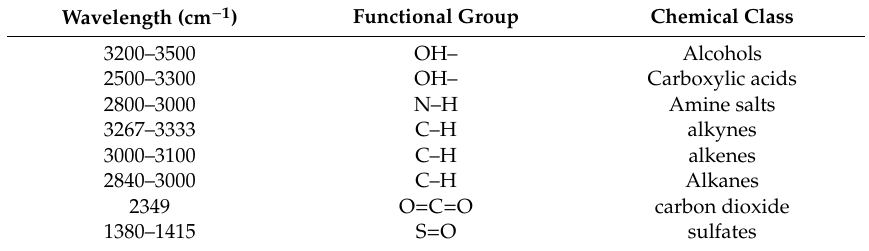
Table 6. Identification of chemicals based on the wavelength of the functional groups by FTIR spectrometer [97].